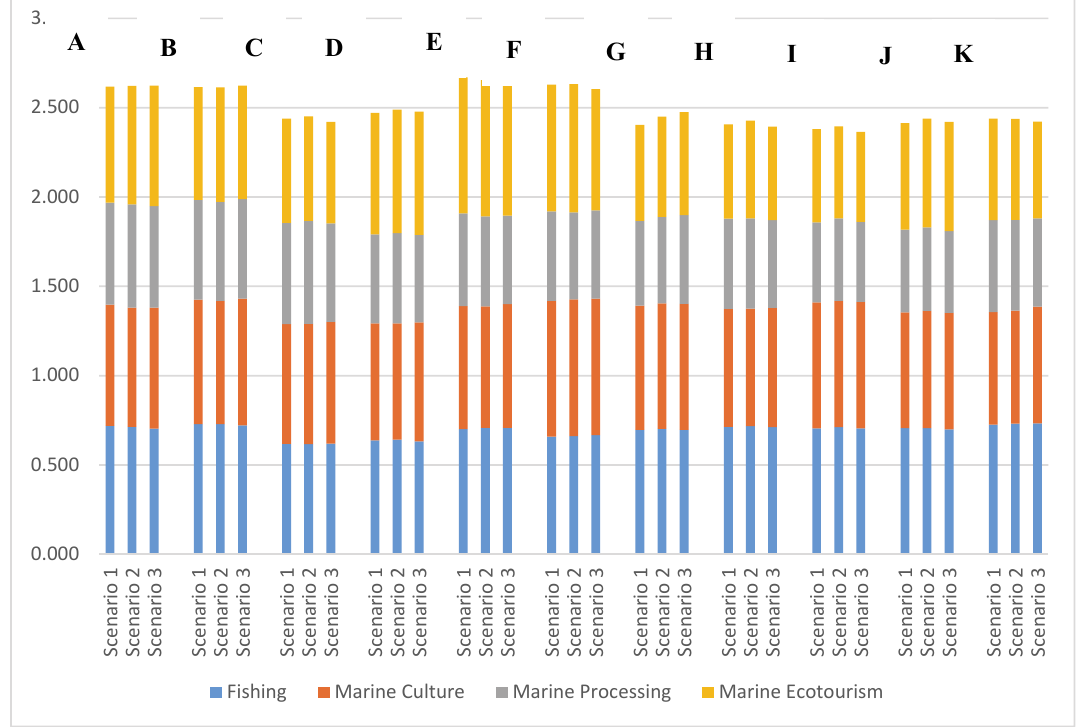
Fig. 4. Sensitivity analysis. A: Kei Kecil Sub-District; B: Kei Kecil Barat Sub-District; C: Kei Kecil Timur Sub-District; D: Kei Kecil Timur Selatan Sub-District; E: Manyeuw Sub-District ; F: Hoat Sorbay Sub-District; G: Kei Besar Sub-District; H: Kei Besar Selatan Sub-District; I: Kei Besar Selatan Barat Sub-District; J: Kei Besar Utara Barat Sub-District; K: Kei Besar Utara Timur Sub-